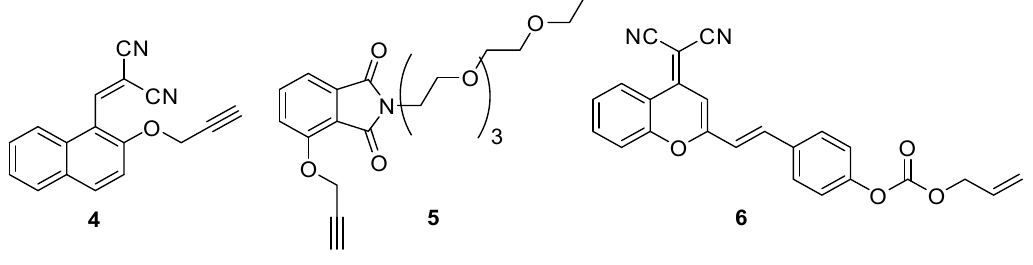
Figure 2. Palladium chemodosimeters.